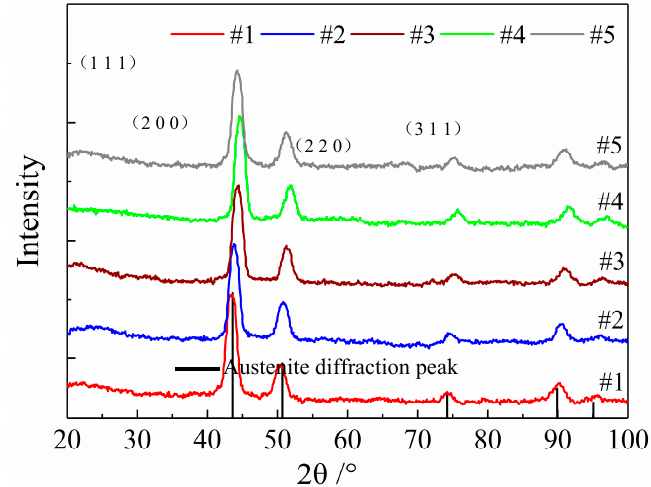
Figure 8. X-ray diffraction patterns of specimens for different cryogenic parameters.